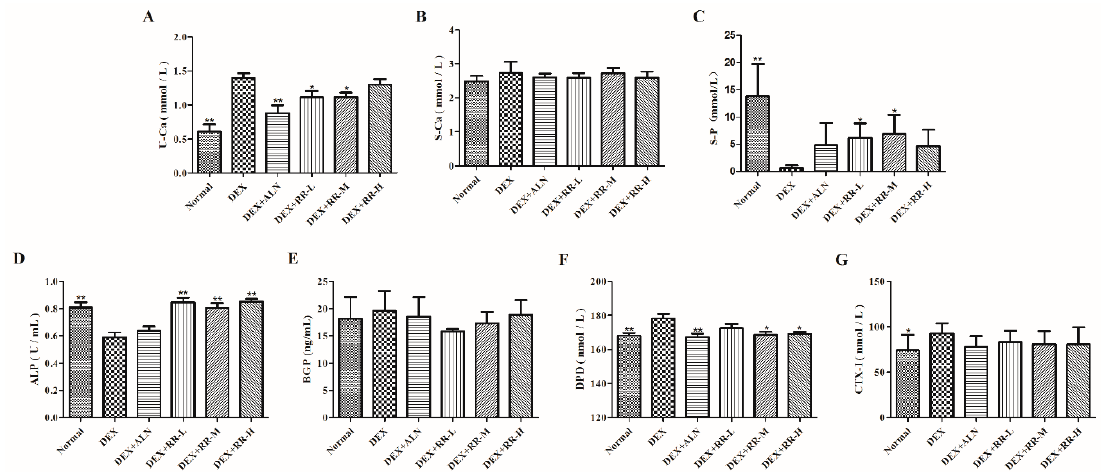
Figure 3. Effects of RR on biochemical markers levels of bone metabolism in DEX-treated rats. ( A ) U-Ca; ( B ) S-Ca; ( C ) S-P; ( D ) ALP; ( E ) BGP; ( F ) DPD; ( G ) CTX-I. Values were expressed as the mean ± SD; n = 7. * p < 0.05, ** p < 0.01 compared with DEX